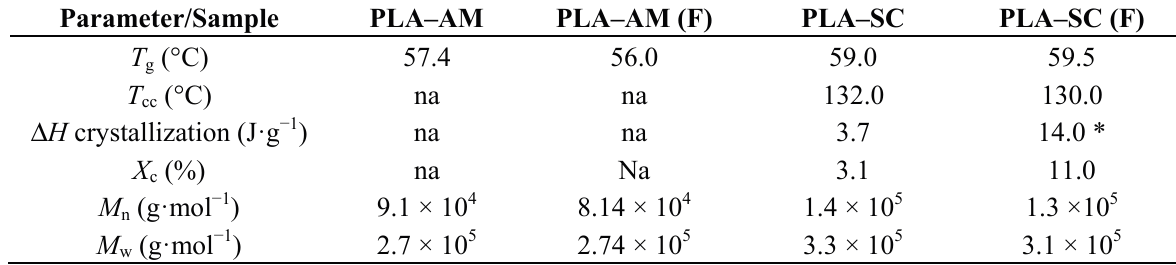
Table 2. DSC /GPC results for PLA–AM and PLA–SC and their films (F).